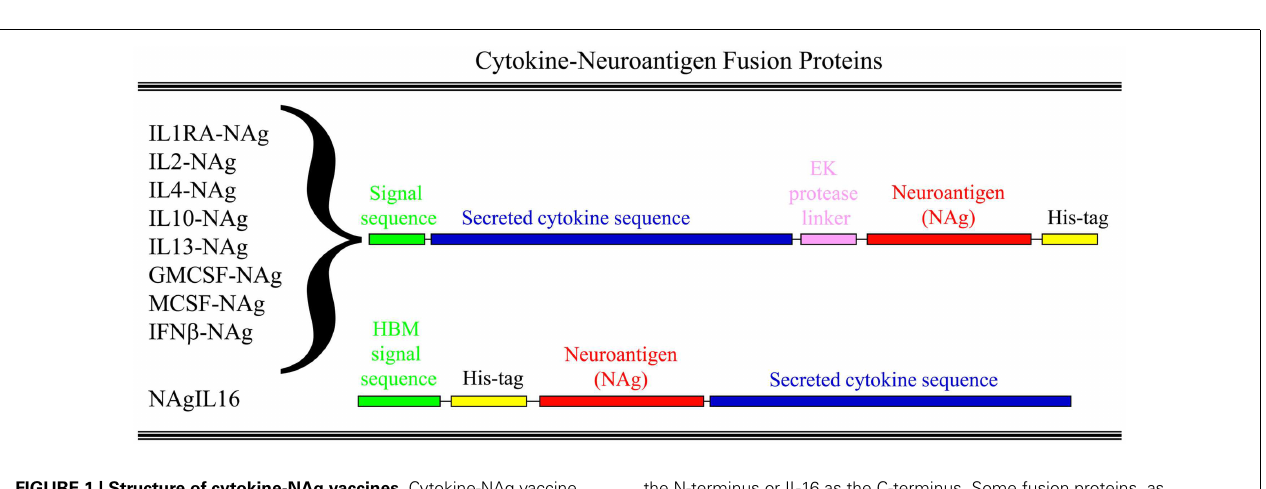
FIGURE 1 | Structure of cytokine-NAg vaccines. Cytokine-NAg vaccine structure is portrayed including those incorporating native IL-1RA (IL-1 receptor antagonist), IL-2, IL-4, IL-10, IL-13, GM-CSF, M-CSF, or IFN-beta as